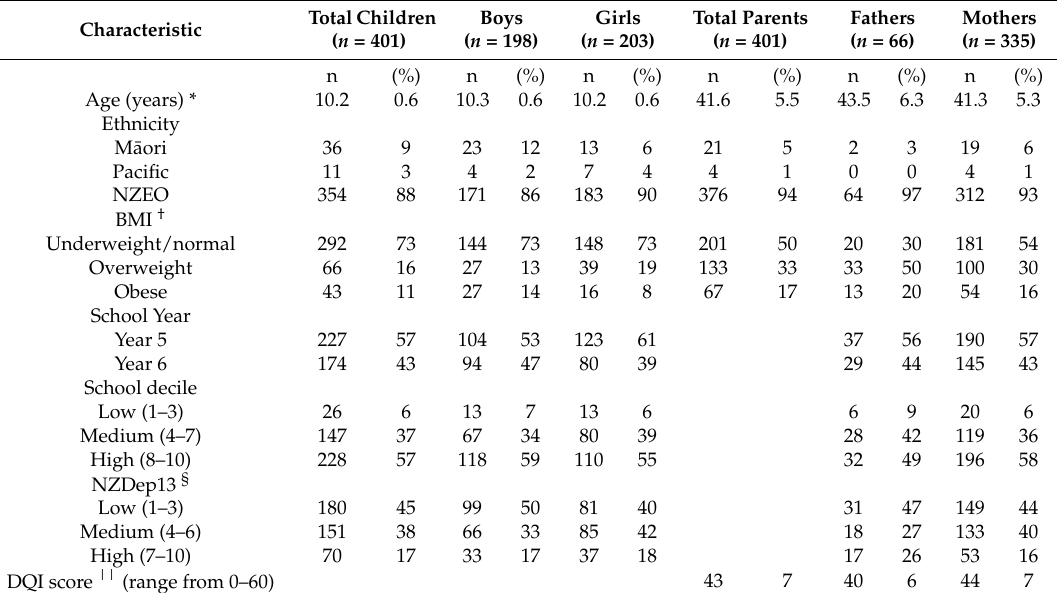
Table 1. Characteristics of child and parent PEDALS